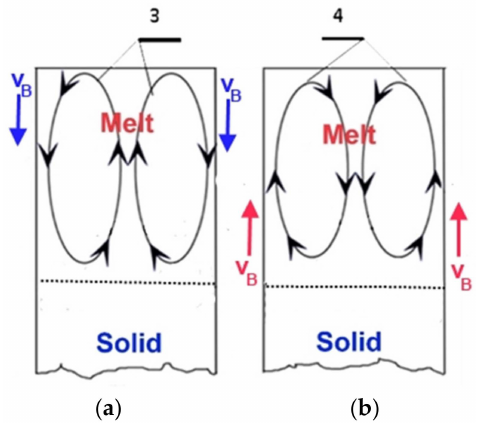
Figure 2. Melt flow developed using traditional TMF inductors, The magnetic field moves from upwards ( a ) to downwards ( b ). 3 and 4: melt flow